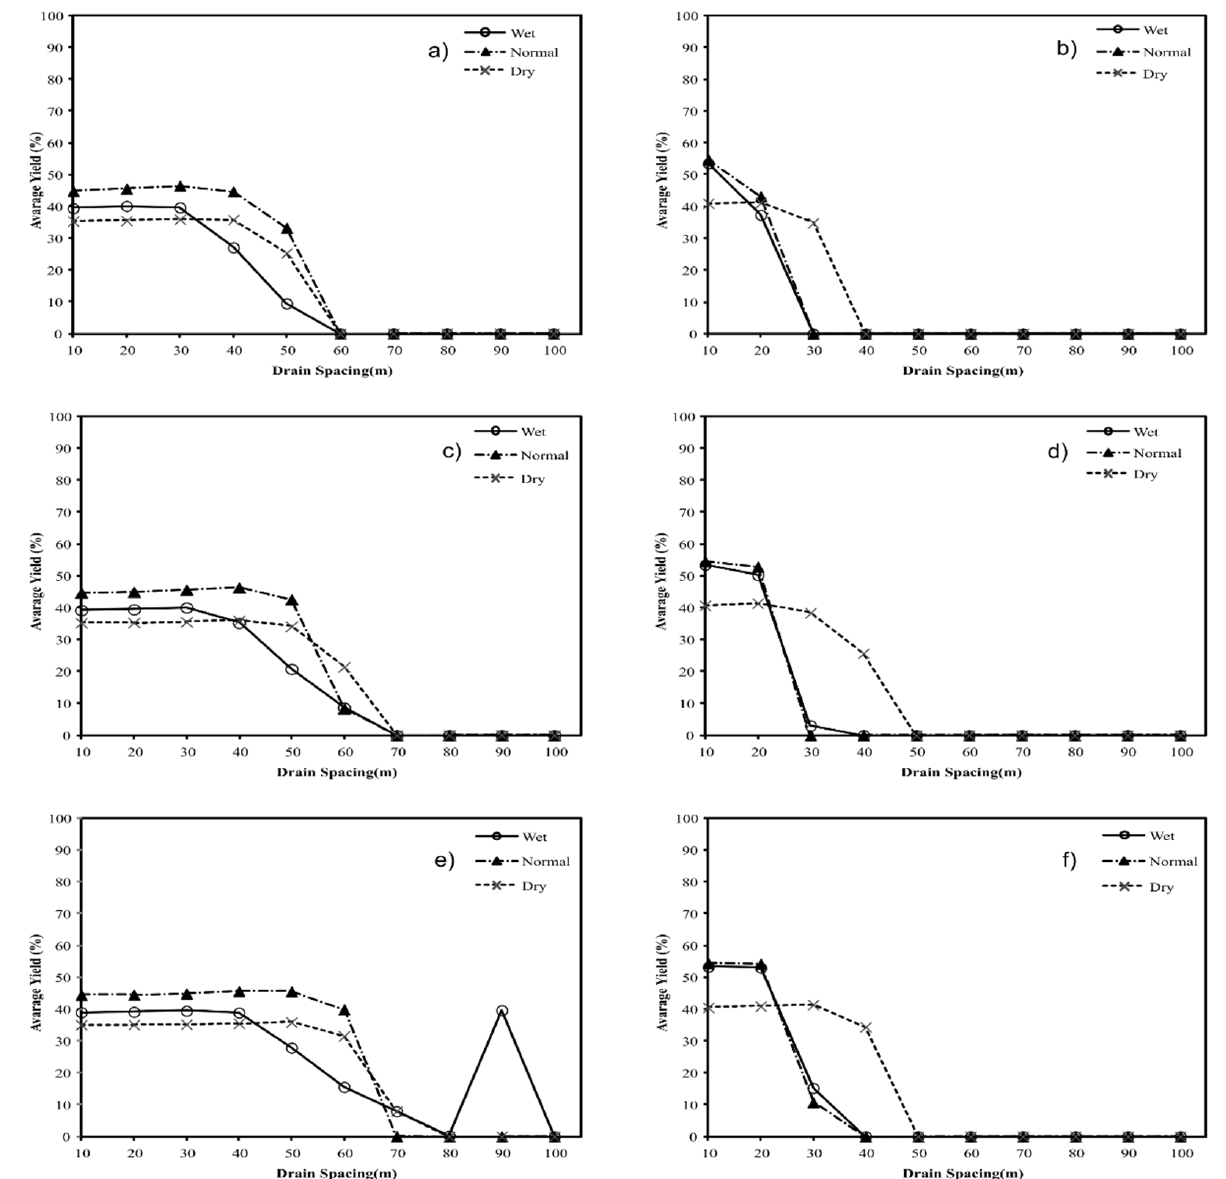
Figure 8. Yield of sugarcane (YT), for normal rainfall and dry and wet years and for drain spaces varying from 10 to 100 m for soil 2 and drain depths of 1.2 ( a , b ), 1.4 ( c , d ) and 1.6 ( e , f ) m for the Barinas ( a , c , e ) and Turen ( b , d , f ) weather